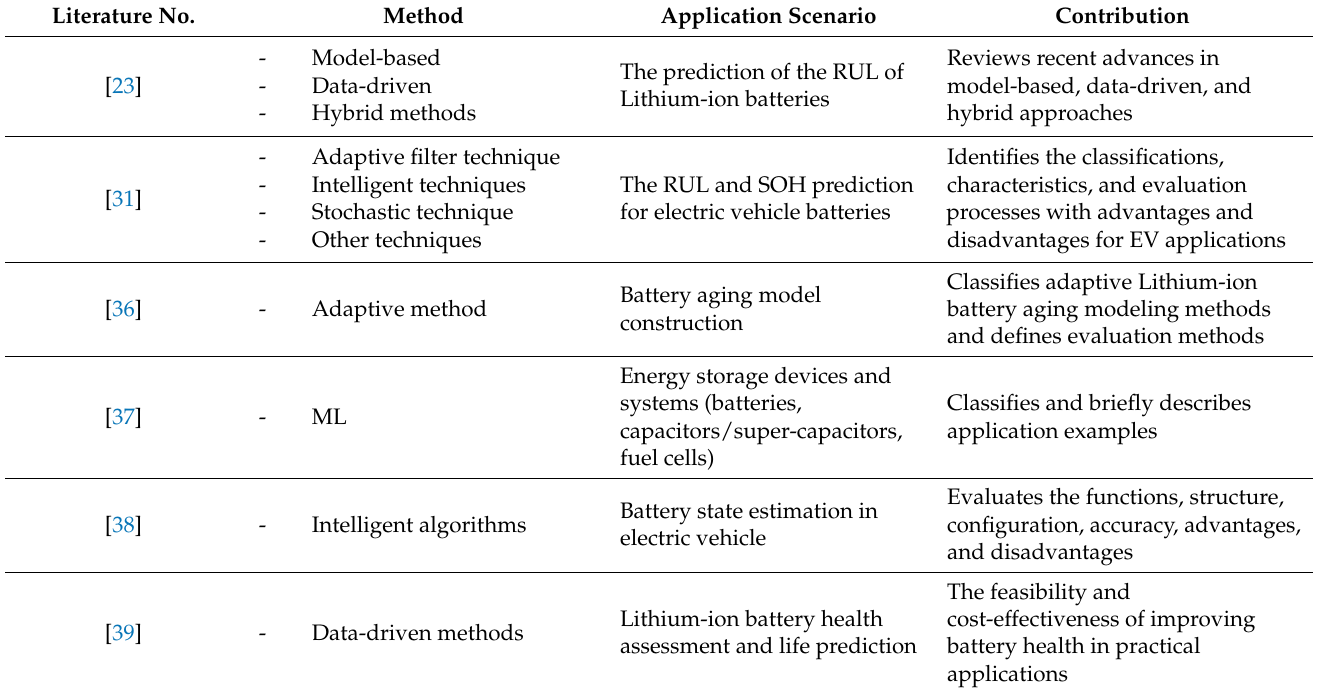
Table 1. The main idea of related review